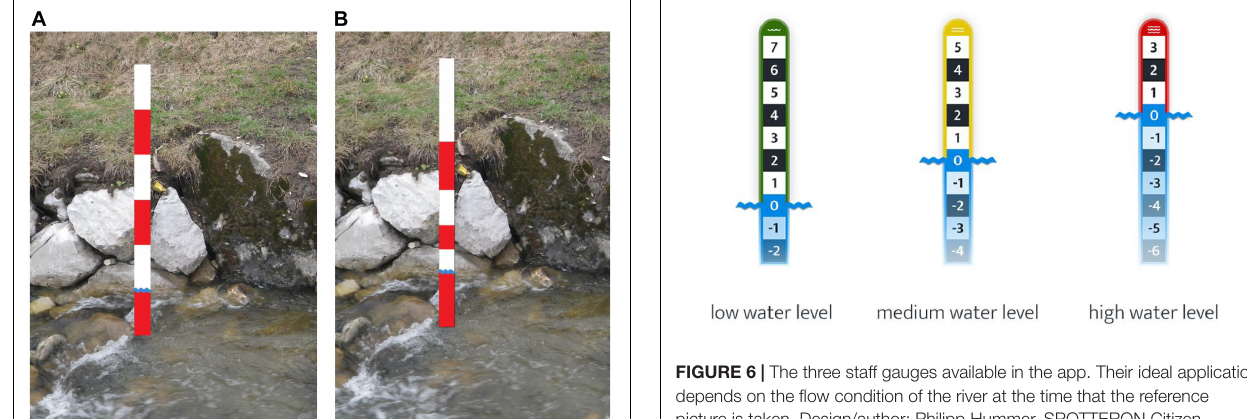
Frontiers in Earth Science |